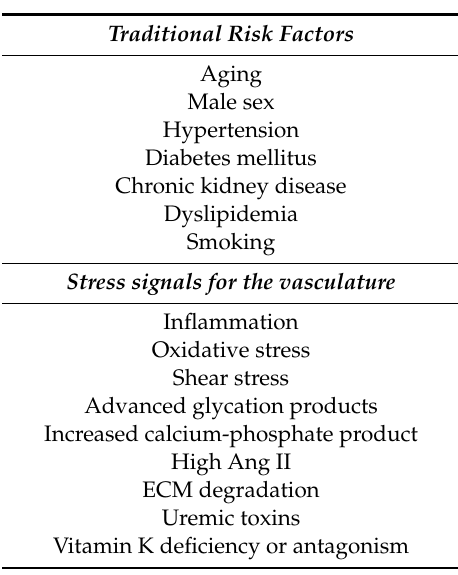
Table 1. Factors which may promote vascular